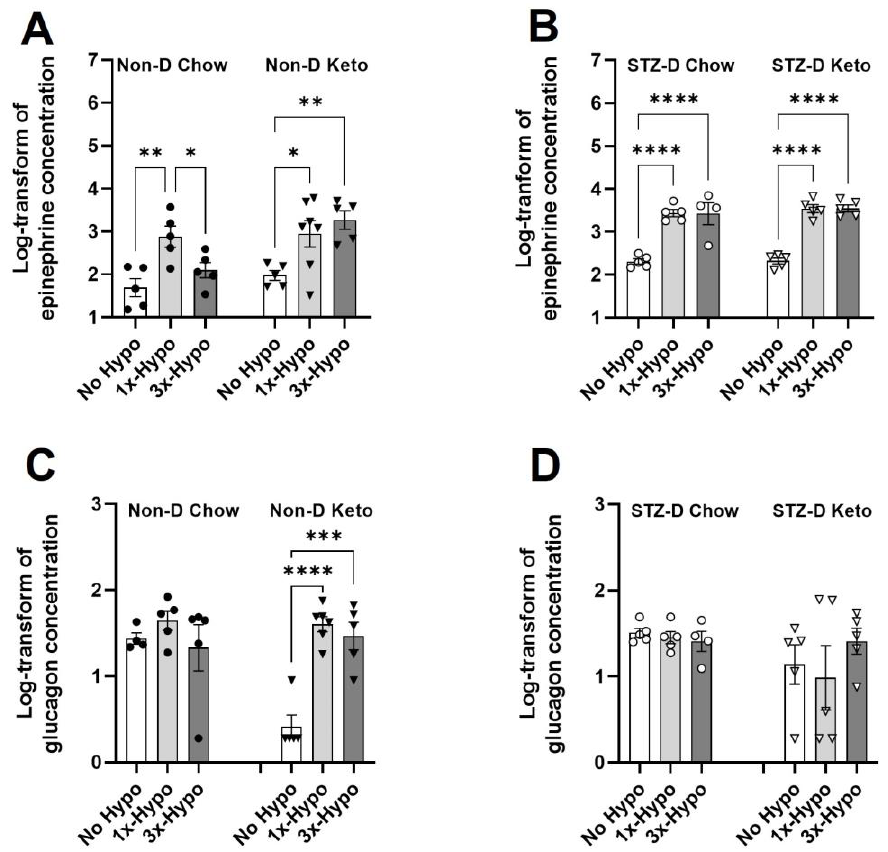
Figure 4. Ketogenic diet differentially affects hypoglycemia counterregulatory hormones in non- diabetic and diabetic rats. ( A ) Recurrent hypoglycemia (3 × -Hypo) reduces epinephrine counterregu- latory response in non-diabetic chow-fed rats; no reduction is observed in non-diabetic keto-fed rats; ( B ) Epinephrine counterregulatory response to recurrent hypoglycemia (3 × -Hypo) is preserved in STZ-diabetic chow- and keto-fed rats; ( C ) Single (1 × -Hypo) or recurrent (3 × -Hypo) hypoglycemia did not induce glucagon counterregulatory response in non-diabetic chow-fed animals, but signifi- cantly increase its release in non-diabetic keto-fed rats; ( D ) No changes in glucagon concentration were detected in STZ-diabetic animals. Log-transformed concentrations of epinephrine and glucagon (pg/mL) were analysed by one-way ANOVA with Holm-Š í d á k multiple comparisons test. Data are mean ± SEM, * p < 0.05, ** p < 0.01, *** p < 0.001, **** p <